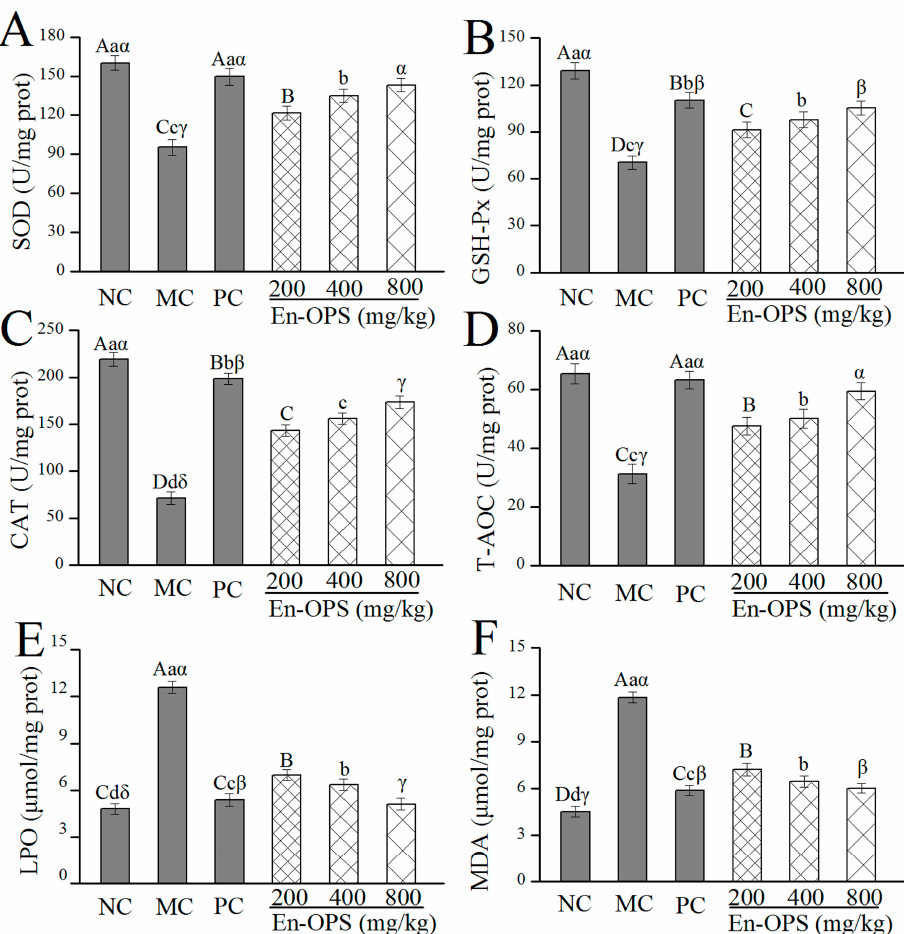
Figure 3. Effects of En-OPS on biochemical parameters in liver of mice. ( A ) superoxide dismutase; ( B ) GSH peroxide; ( C ) catalase; and ( D ) total antioxidant capacity, and contents of ( E ) lipid peroxide and ( F ) malondialdehyde. The values were reported as the mean ± S.D. of 10 mice per group. Bars with different letters were significantly different ( p < 0.05). The statistical significance of the differences between the groups were analyzed using Tukey’s tests in the software package (SAS 9.3). A value of p < 0.05 was regarded as statistically significant.